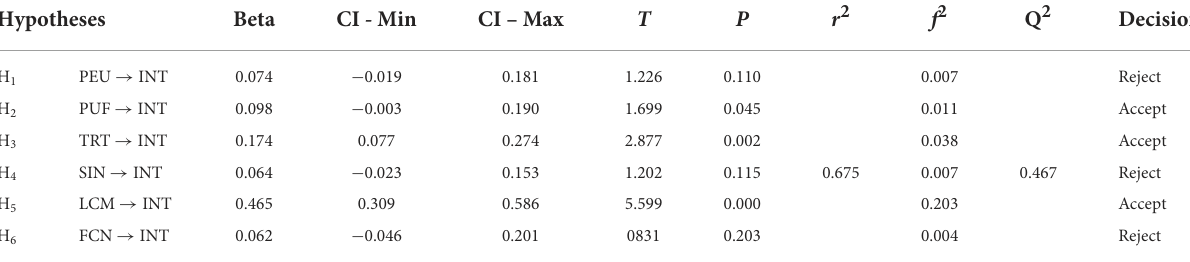
TABLE 6 Path coefficients.